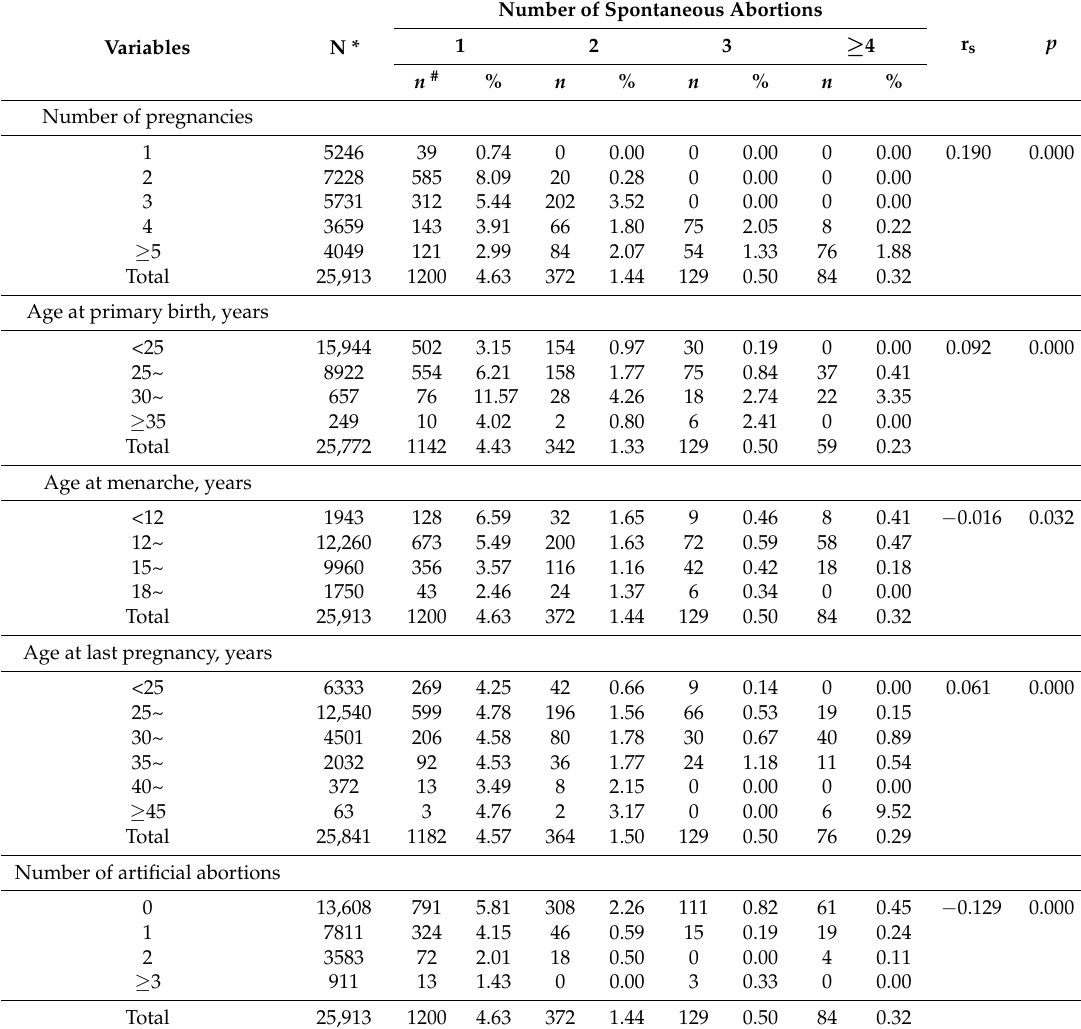
Table 4. Relationship between Reproductive Status and Spontaneous Abortion in the Jinchang Cohort Study. Number of Spontaneous Variables N *